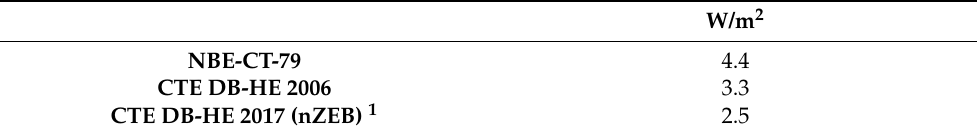
Table 6. Lighting power density according to the year of application.